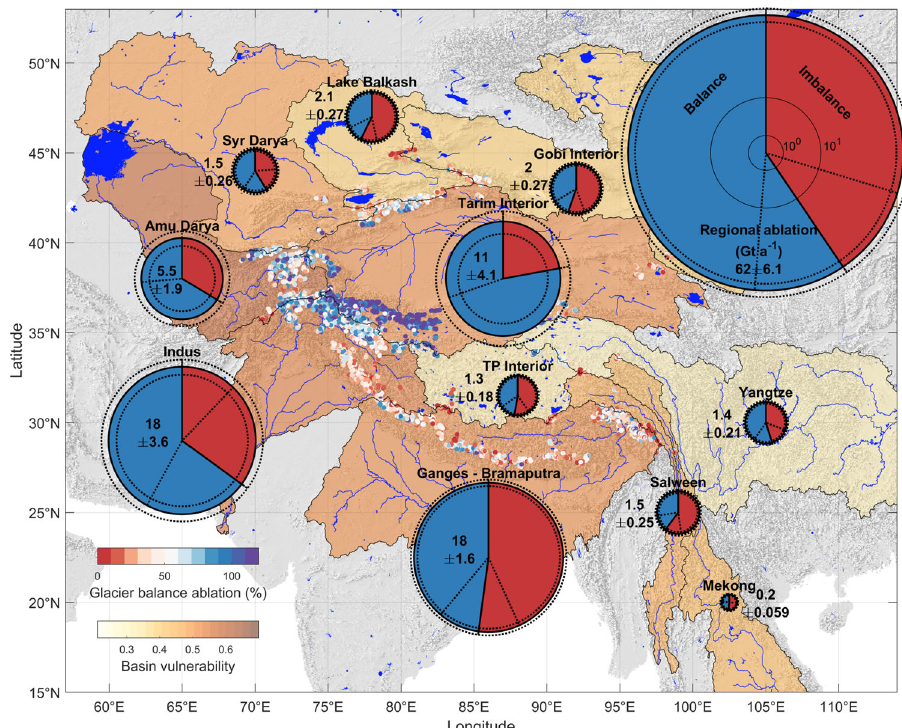
Fig. 3 The quantity and context of glacier ablation for principal drainage basins in High Mountain Asia. Analyzed glaciers are colored according to the portion of total annual ablation that is compensated by accumulation, which is greater than 100% for glaciers gaining mass. The portion of balance ablation derived from our results is shown for major river basins, indicating uncertainty with the dashed lines, and scaled by area according to the total estimated glacier ablation within each ( “ Methods ” , Supplementary Tables 4, 5). Basin vulnerability is colored according to the global range 3 . Background is a hillshade of the GTOPO30 dataset sourced from the USGS